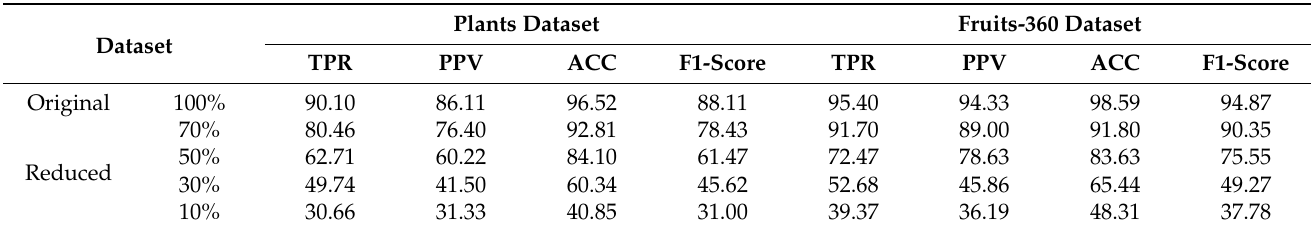
Table 18. Comparison of accuracies achieved by the proposed PI-CNN in the original and reduced datasets. The accuracies were achieved in the Plants and Fruits-360 dataset (unit: %).